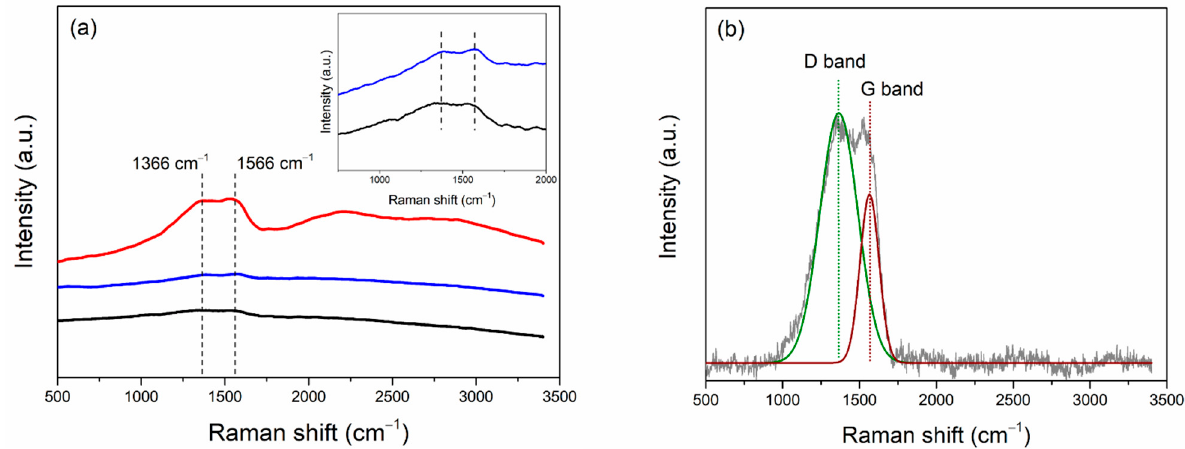
Figure 5. ( a ) Raman spectra of Bi/Sn electrode, 0.1Bi/Sn (black), 0.05Bi/Sn (red), and 0.01Bi/Sn (blue) and magnified scale (insert) of Raman spectra of 0.01Bi/Sn and 0.1Bi/Sn electrodes, and ( b ) Raman spectra analysis of 0.05Bi/Sn electrode after CO 2 RR test at − 1.1 V vs. Ag/AgCl.